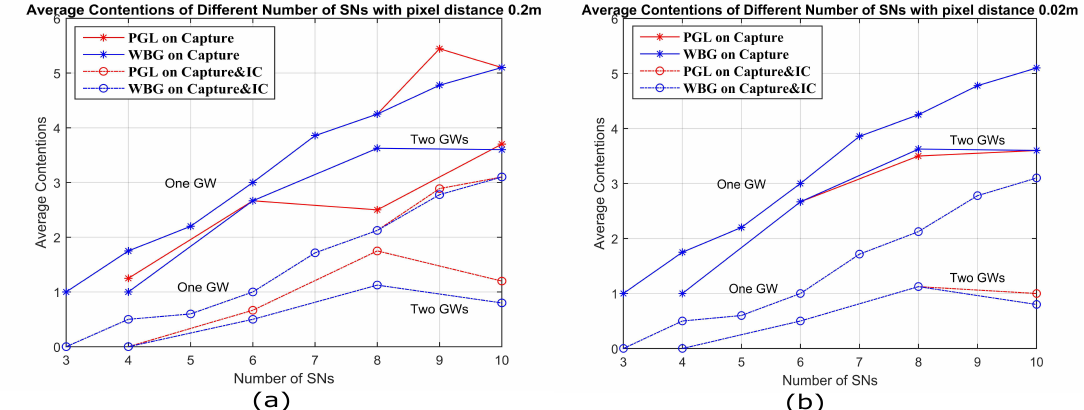
Figure 11. Average Contention for different number of SNs with one and two GWs, by WBG and PGL algorithms with capture only and capture with IC for different pixel